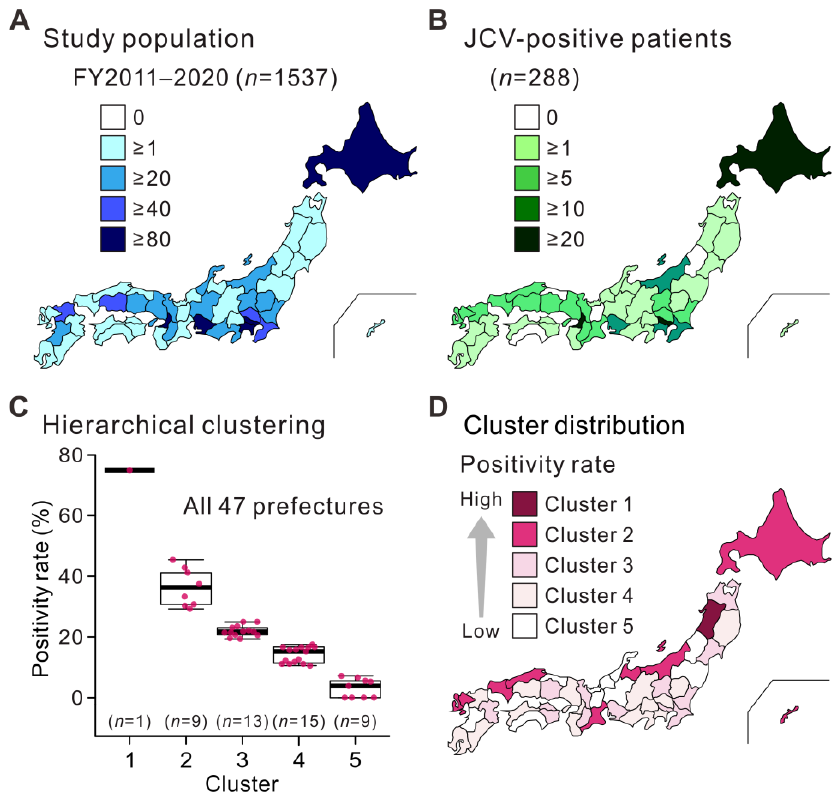
Figure 2. Geographic distribution patterns of individuals tested for JCV in the CSF. All individuals tested ( A ) and patients with JCV-positive CSF ( B ) during the study period (FY2011–2020) are shown. Each prefecture in Japan is color-coded according to the number of individuals. ( C ) The hierarchical cluster analysis of the proportion of patients with JCV-positive CSF among individuals in each prefecture. Japanese prefectures were divided into five clusters according to the CSF-JCV-positivity rates. The dots indicate the positivity rates in each prefecture. The thick horizontal line within each box is the median, and the lower and upper boundaries are the 25th and 75th percentiles, respectively. Vertical whiskers extend to minimum and maximum values. ( D ) Distribution of hierarchical clusters based on CSF-JCV-positivity rates in Japan. Each prefecture is color-coded according to cluster type.